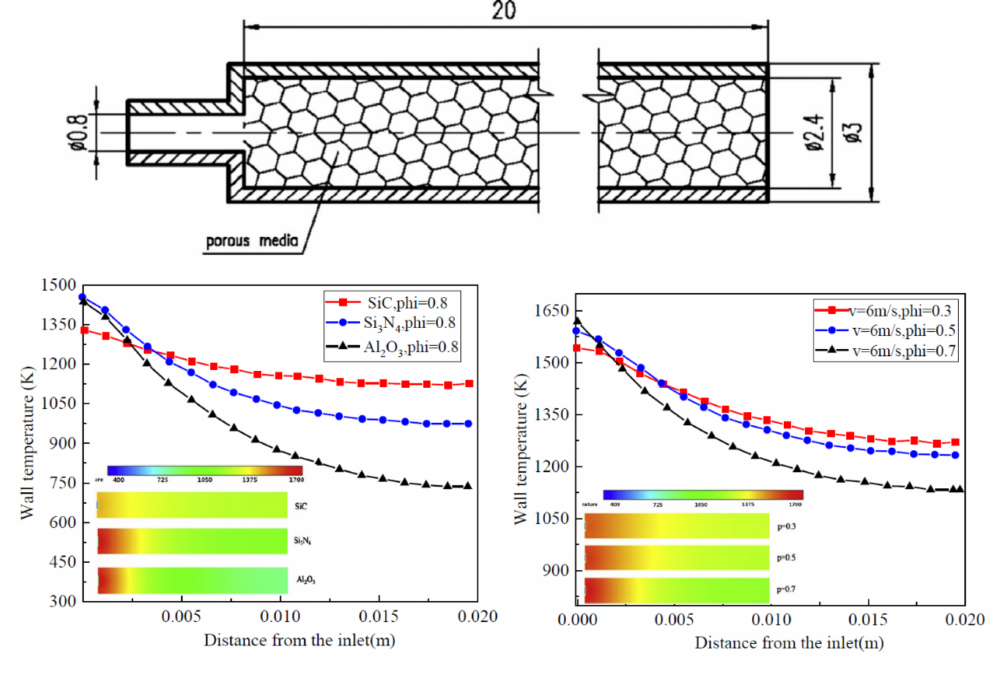
Figure 29. Temperature distributions of micro combustor